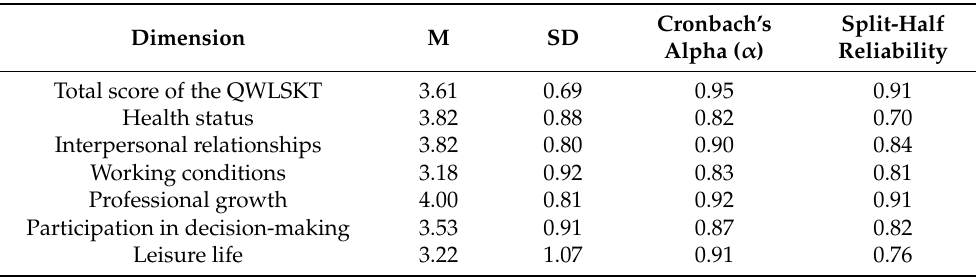
Table 3. Item means, standard deviations, and reliability of the quality of work life scale for kinder- garten teachers (QWLSKT).